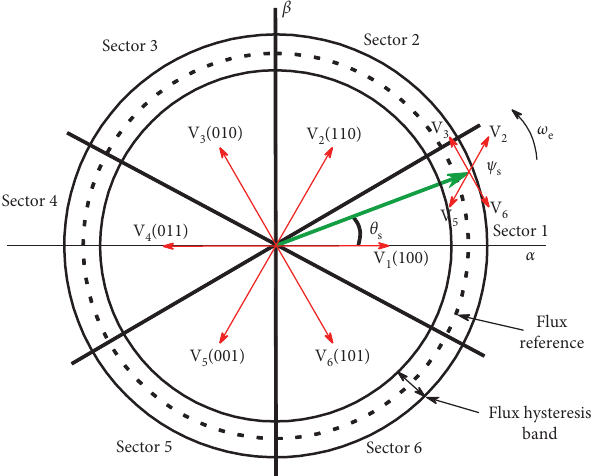
Figure 3: Active voltage vectors and sectors of the flux vector space.